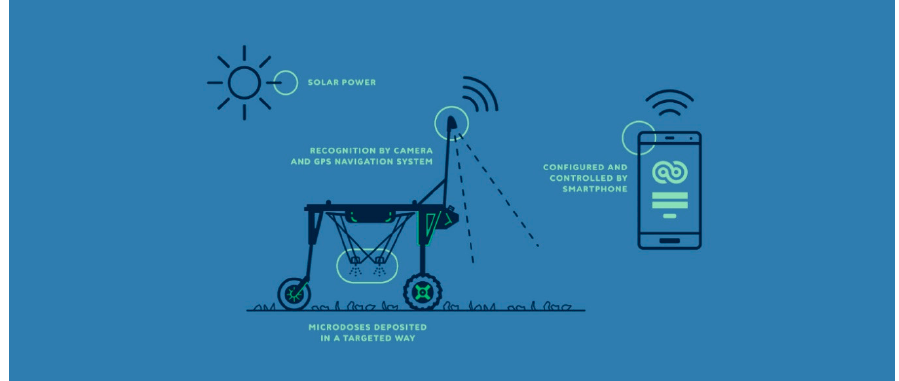
Figure 6. A commercially available autonomous robotic solar-powered weeder. Its light-weight (130 kg) minimizes soil compaction (ecoRobotix, Yverdon-les-Bains, Switzerland).